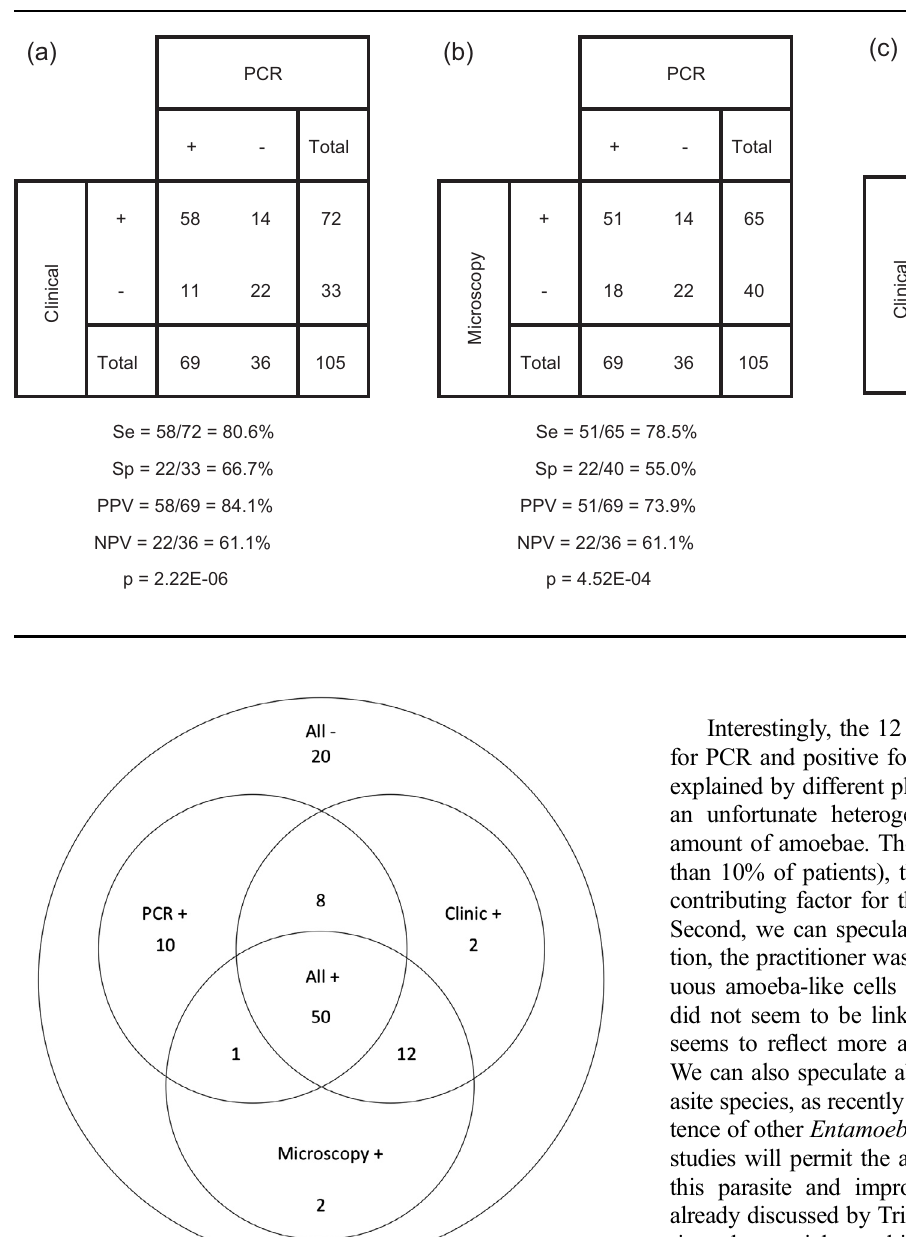
Table 1. Comparison of diagnosis methods and statistical indicators. PCR was compared with clinical diagnosis (a), and with results obtained by microscopy (b); diagnosis by microscopy was also compared with clinical diagnosis (c).